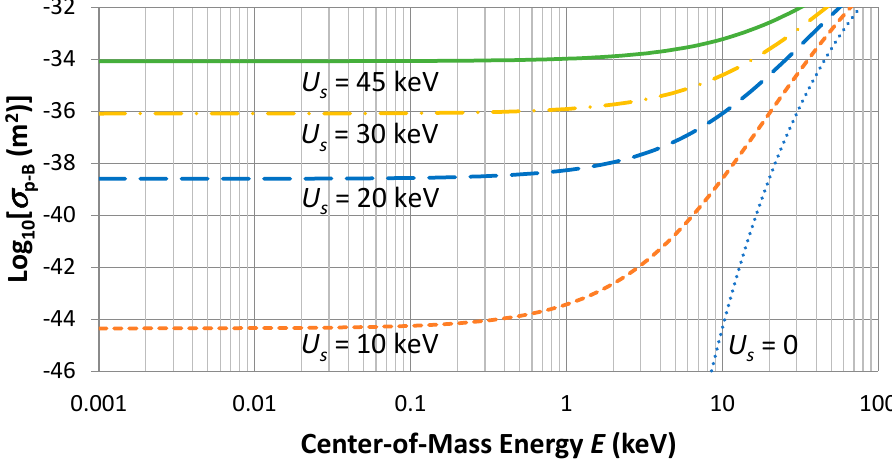
Figure 1. p- 11 B cross section as function of particle energy for the screening electron densities up to U s = 45 keV. The cross section below E = 1 keV grows over 10 orders of magnitude (from 10 − 44 to 10 − 34 m 2 ) when U s increases from 10 to 45 keV.